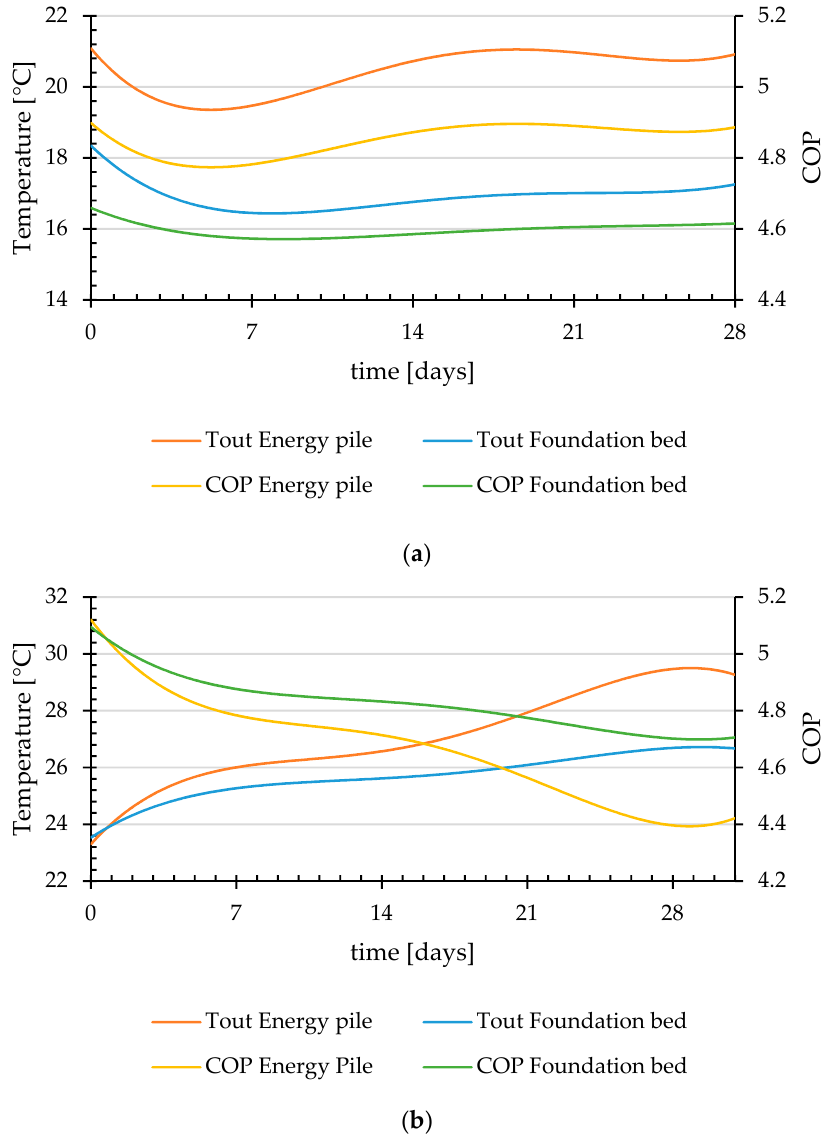
Figure 11. Performance comparison between the two types for the months of ( a ) February and ( b ) July.